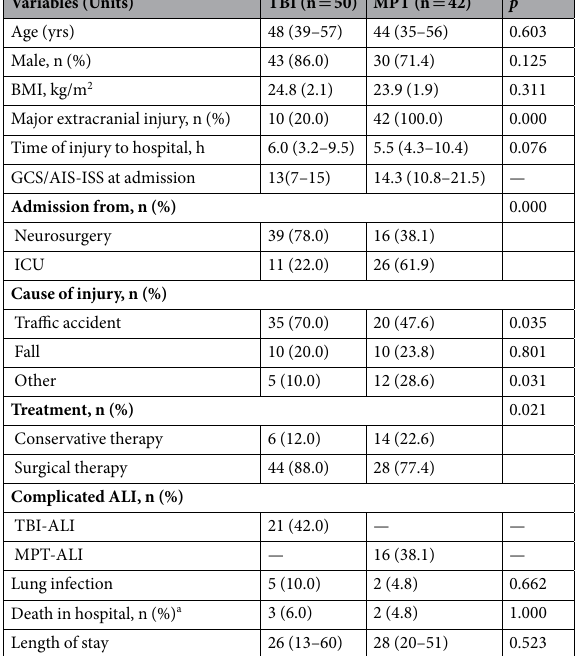
Table 1. Patient Demographics and Baseline Characteristics (N = 92). —, not applicable. p , difference between the two groups as determined by two-tailed Student’s t -tests or nonparametric Mann-Whitney U tests. Continuous variables are expressed as the means (SE) or medians (IQR), and categorical variables are expressed as n (%). AIS-ISS, Abbreviated Injury Scale-Injury Severity Score; ALI, acute lung injury; BMI, body mass index; GCS, Glasgow Coma Scale; MPT, multiple peripheral trauma; TBI, traumatic brain injury. a Patients who died more than 7 days after